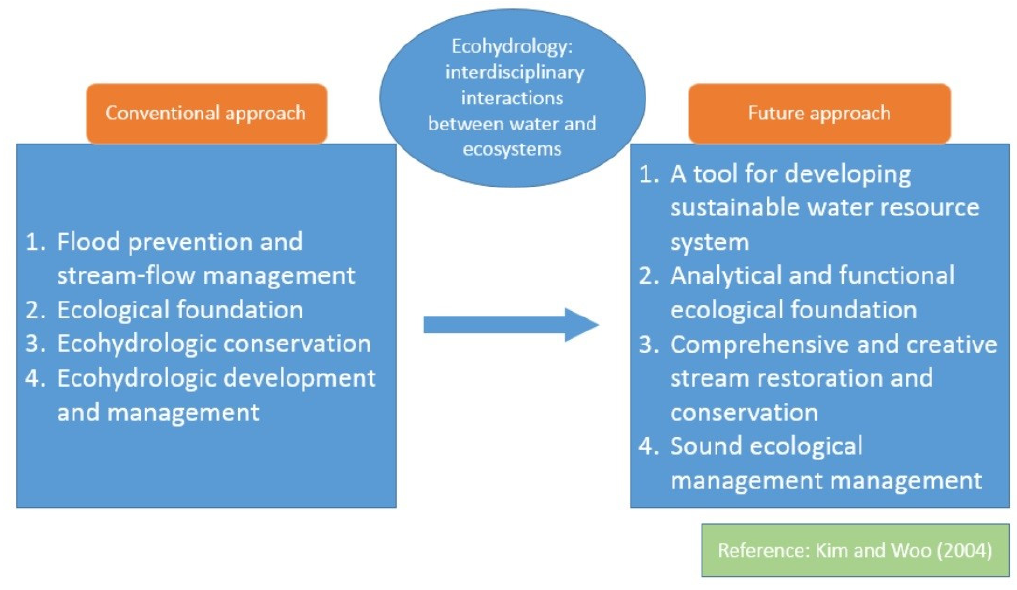
Figure 1. Paradigm shift under conceptual model of eco-hydrology.